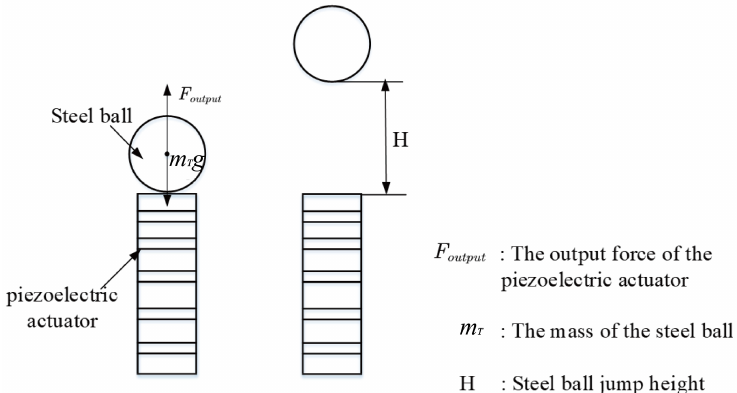
Figure 4. The stress analysis of the steel ball bounced by the piezoelectric actuator in the